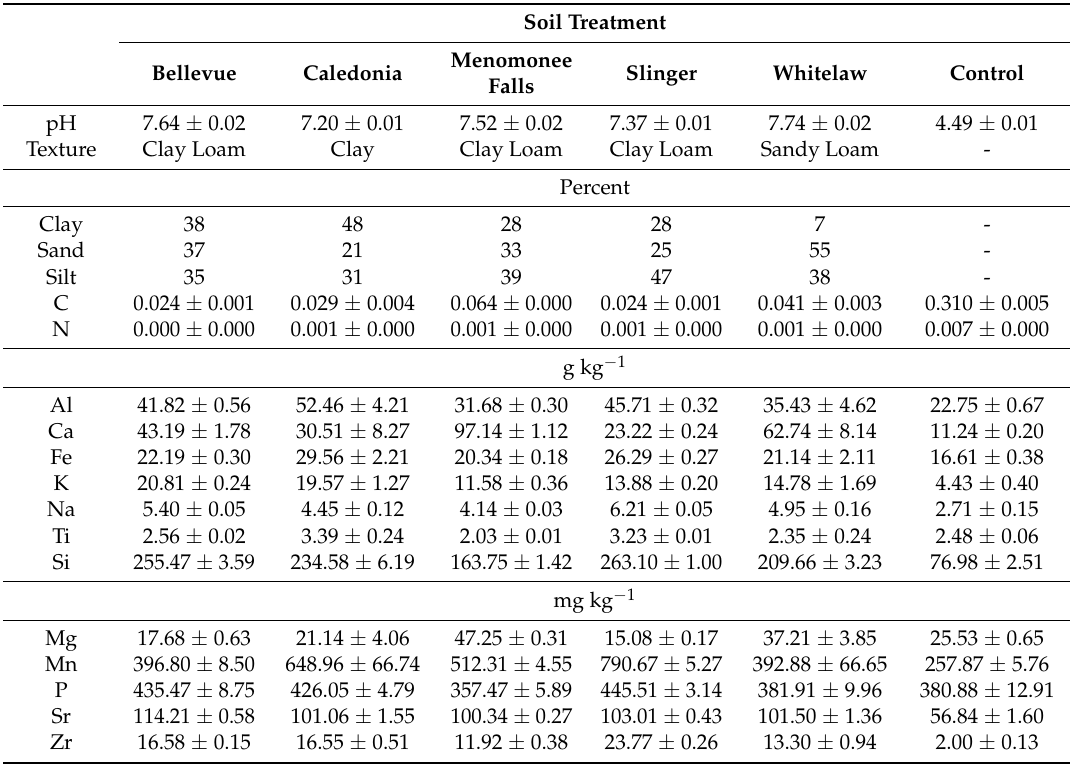
Table 1. pH, texture, and chemical properties of soils collected from five landfills in eastern Wisconsin, USA in a study assessing the relationships among root–shoot allocations, early growth, and health of hybrid poplar and willow clones when grown in the landfill soils for 65